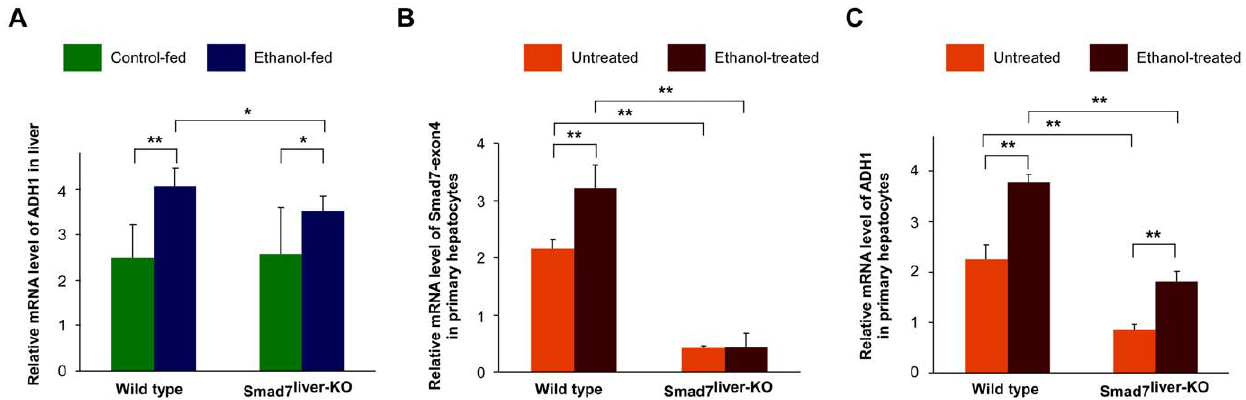
Figure 6. Alcohol-induced ADH1 expression is reduced by Smad7 deletion. (A) Analysis of ADH1 mRNA level of the mouse liver as of Figure 5A by real-time PCR. The data are shown as mean 6 SD. * and ** indicates p , 0.05 and p , 0.01 respectively. (B) and (C) Analyses of the mRNA levels of Smad7 and ADH1 in primary hepatocytes. Primary hepatocytes isolated from wild type and Smad7 liver-KO mice were incubated with or without ethanol (100 mmol/L) for 24 h. The mRNA were isolated and used in real-time PCR. The data are shown as mean 6 SD with * for p , 0.05 and ** for p , 0.01 between the groups as indicated. doi:10.1371/journal.pone.0017415.g006 PLoS ONE |